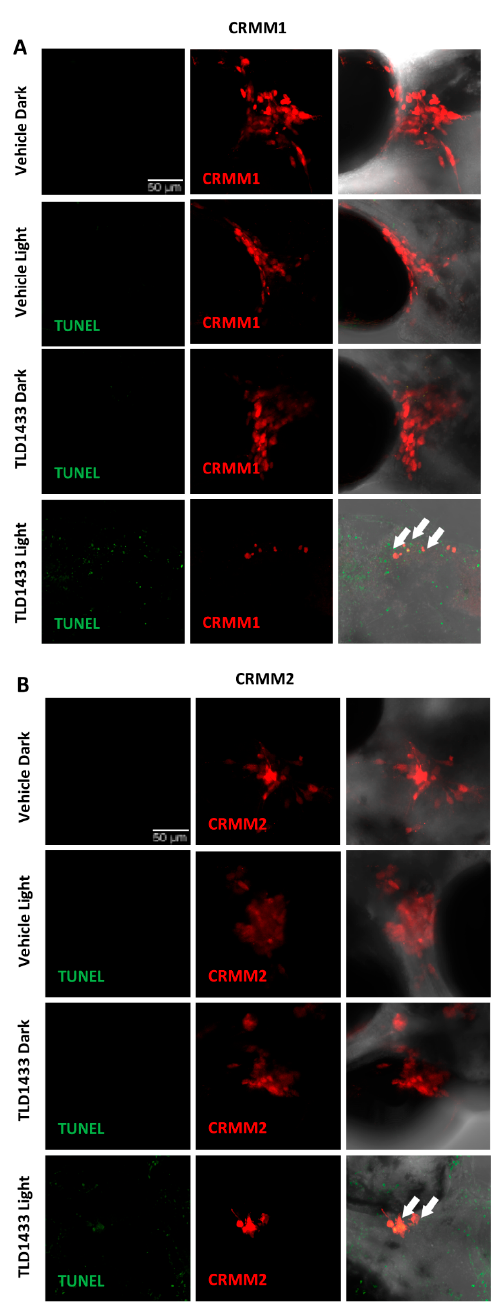
Figure 10. TUNEL assay of in CRMM1 and CRMM2 orthotopic model after RO of TLD1433. Red fluorescent CRMM1 ( A ) and CRMM2 ( B ) cells were injected at 2dpf behind the ZF eye and divided into four groups for drug treatment. RO administration of vehicle control and TLD1433 was performed as described in Figure 9C,E. After dark or light exposure (21 mW / cm 2 , 114 J.cm − 2 , 520 nm) embryos were fixed and TUNEL staining was performed. Representative images of embryos are shown in this figure. ( A , B ) In TLD1433 light groups nuclear DNA fragmentation by nucleases is detected by co-localization of green (DNA fragments) and red signal of engrafted CM cells, depicted as yellow signal and marked by white arrows. In control dark, control light, TLD1433 dark, there are no positive green apoptotic tumour cells observed. Background green signal in TLD1433 light groups, does not co-localized with cytosolic red signal, which is diminished in degraded cells and TUNEL stains only the DNA breaks in these CM apoptotic cells. Experiment was performed 3 times with a group size of 10